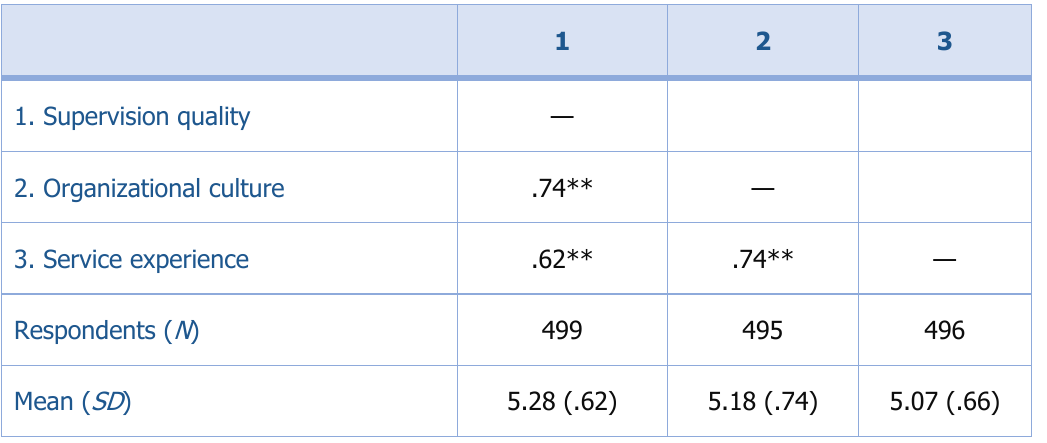
Table 3. Bivariate Correlations Among Dependent